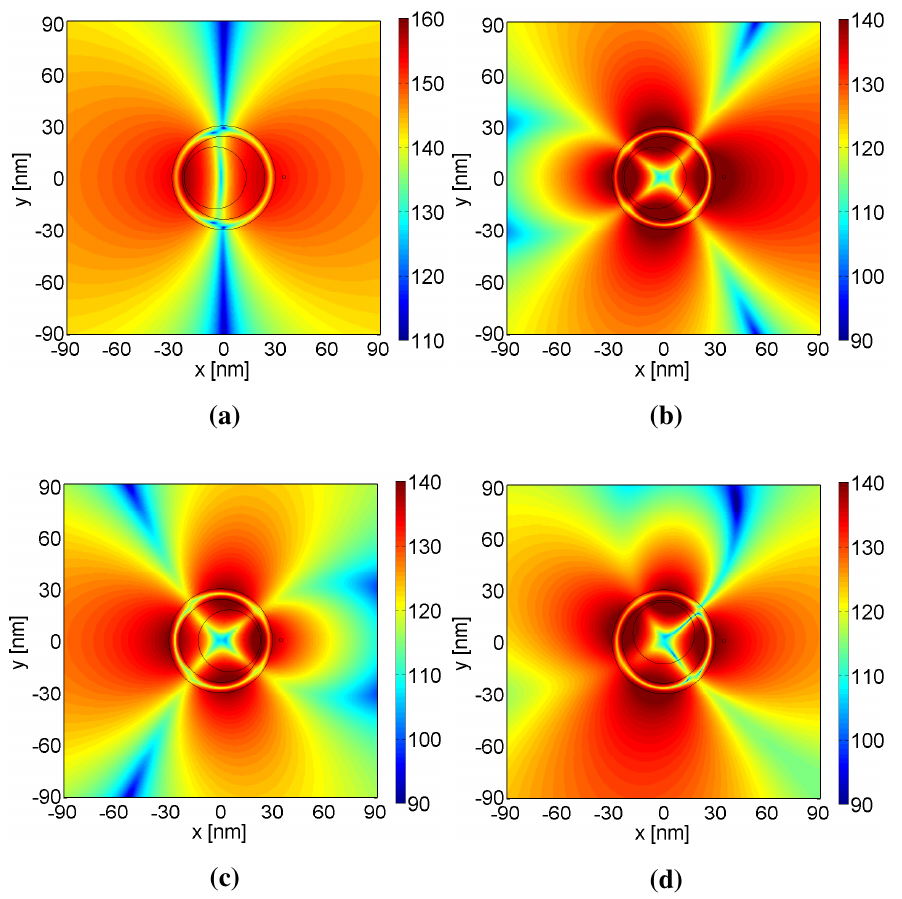
| H | , for the optimized eccentric 3L 10